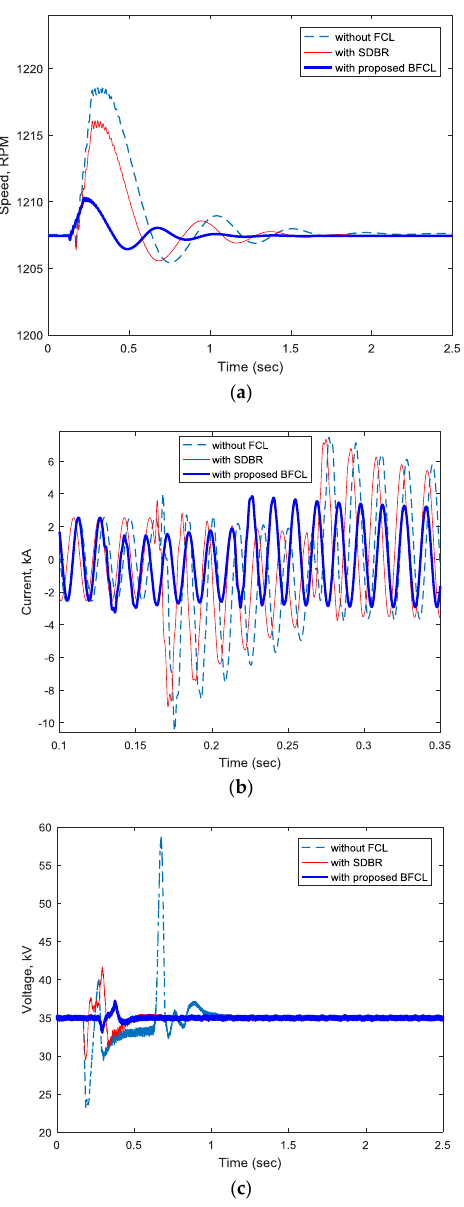
Figure 7. Comparative transient response of fixed speed wind integrated VSC-HVDC system subject to symmetrical fault at PCC ( a ) Induction machine speed ( b ) Induction machine stator current ( c ) DC link voltage.